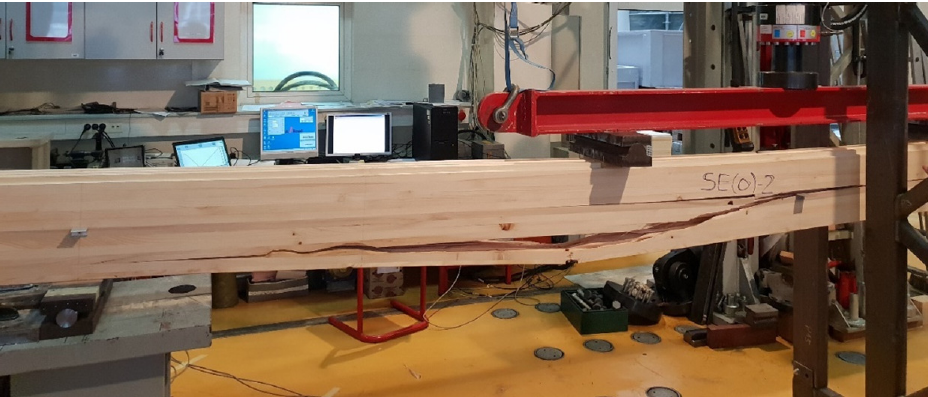
Figure 15. Comparison of the force-displacement curve for strong-axis bending of samples with elliptical and circular cavities.